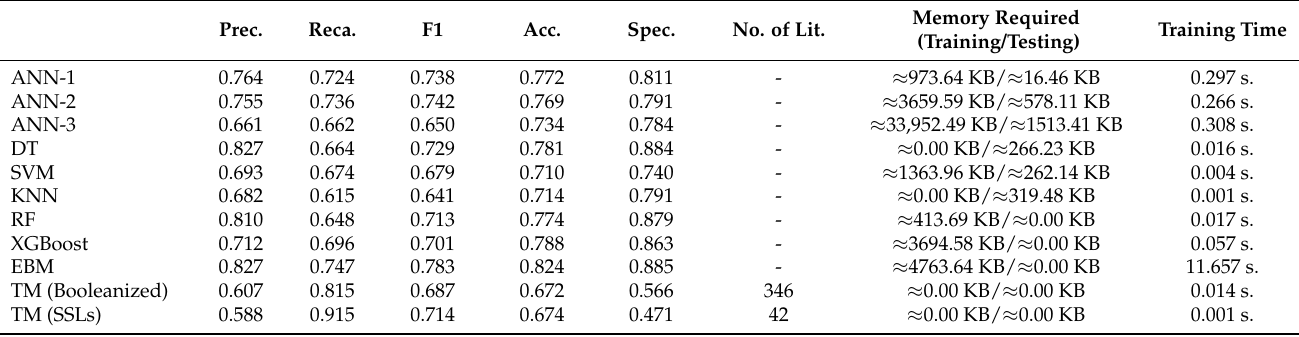
Table 22. Performance comparison for Heart Disease